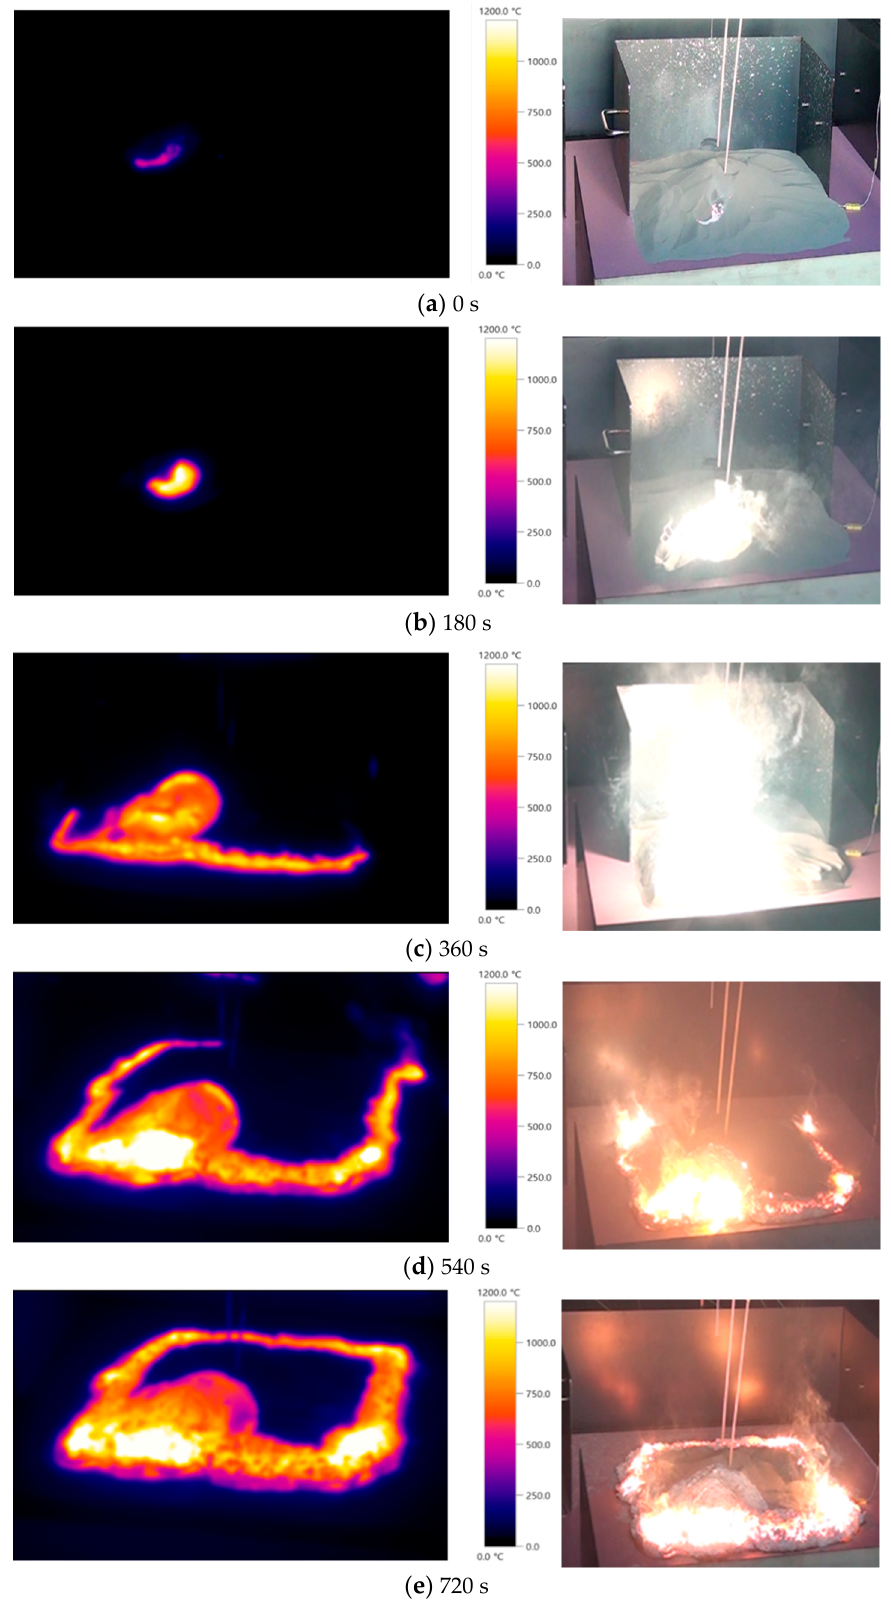
Figure 12. Temperature distribution of magnesium combustion over time ( a – e ).